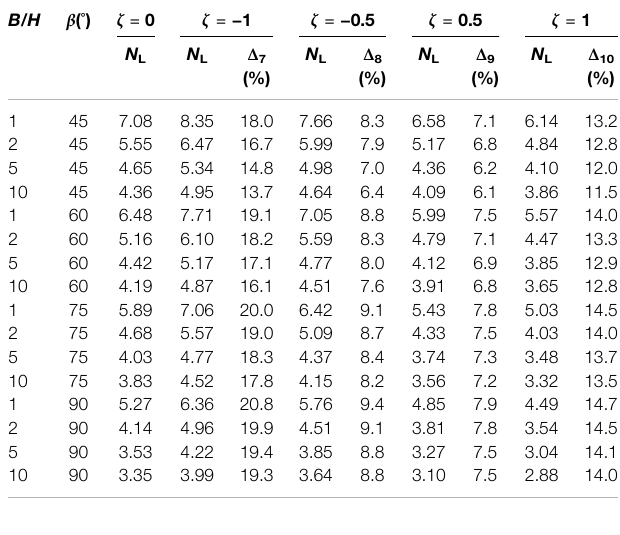
TABLE 5 | Effects of the vertical seismic effect proportion coef fi cient ζ on stability factor N L ( k h (cid:1)